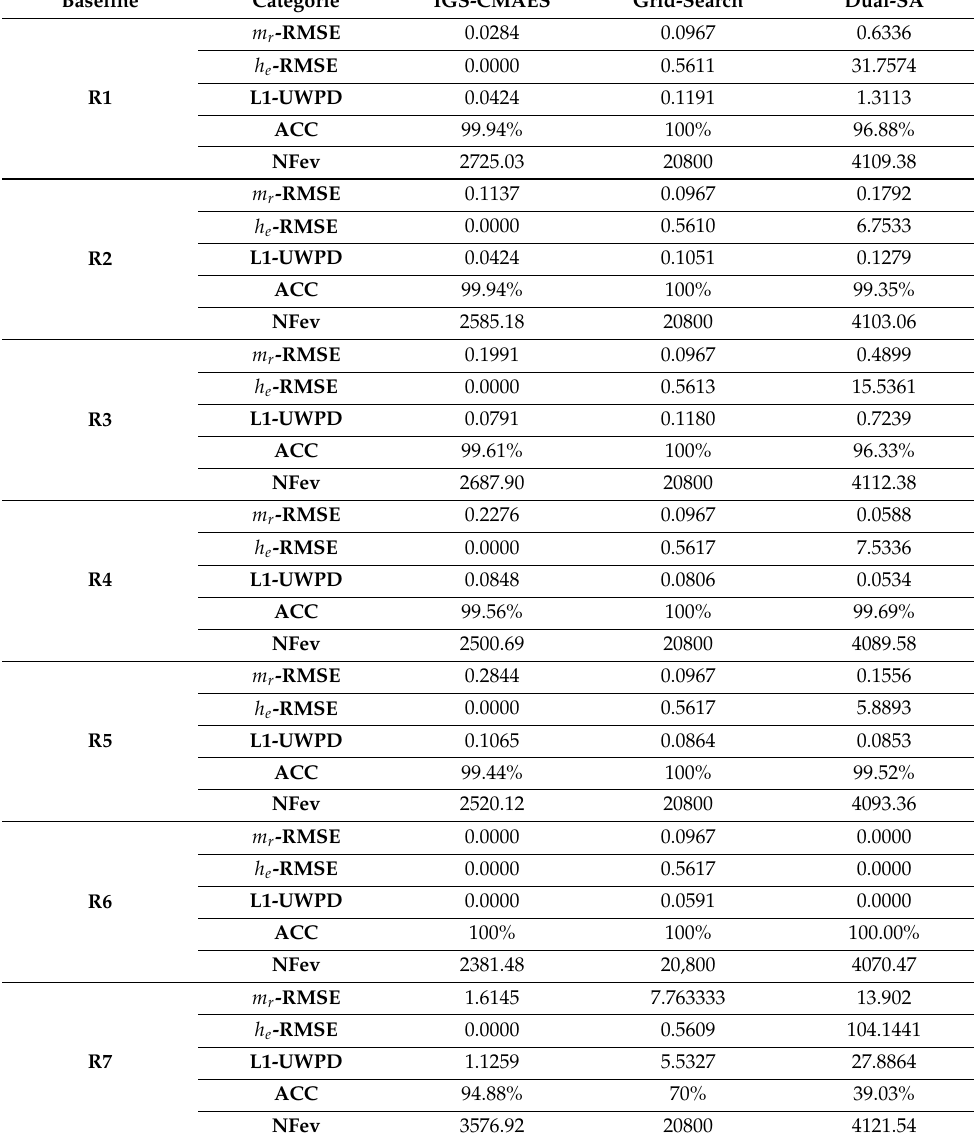
Table 3. Quantitative comparison for simulated data using IGS-CMAES with two other global